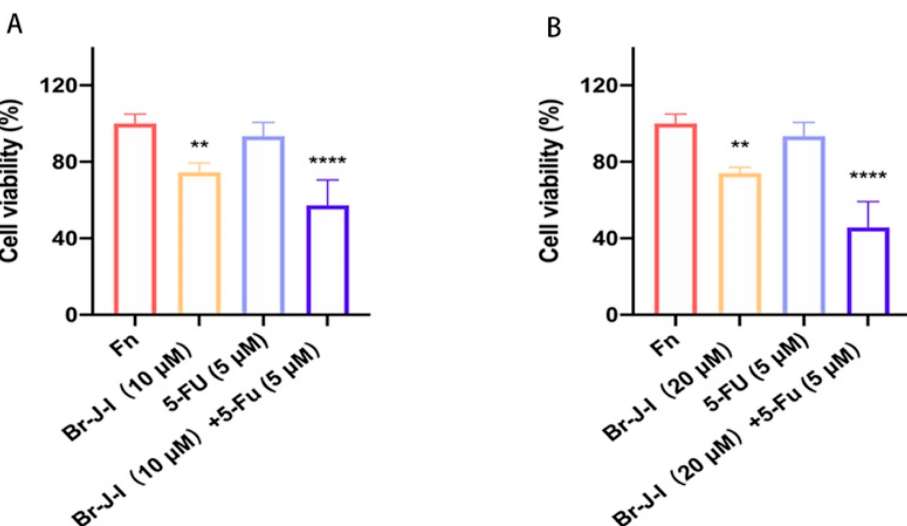
Figure 9. Br-J-I synergizes with 5-FU to inhibit proliferation of HCT116 cells. The HCT116 cells co- cultured with Fn were treated with 5 -FU (5 µ M) alone or in combination with different concentrations of B-J-I for 48 h and MTT assay was conducted to determine cell viability. ( A ) 10 μ M B Br-J-I /5 μ M 5-FU, ( B ) 20 μ M B Br-J-I /5 μ M 5-FU. Results were representative of three independent experiments performed in four replicates and were expressed as mean ± SEM. ** p < 0.01, **** p < 0.0001, vs. Fn